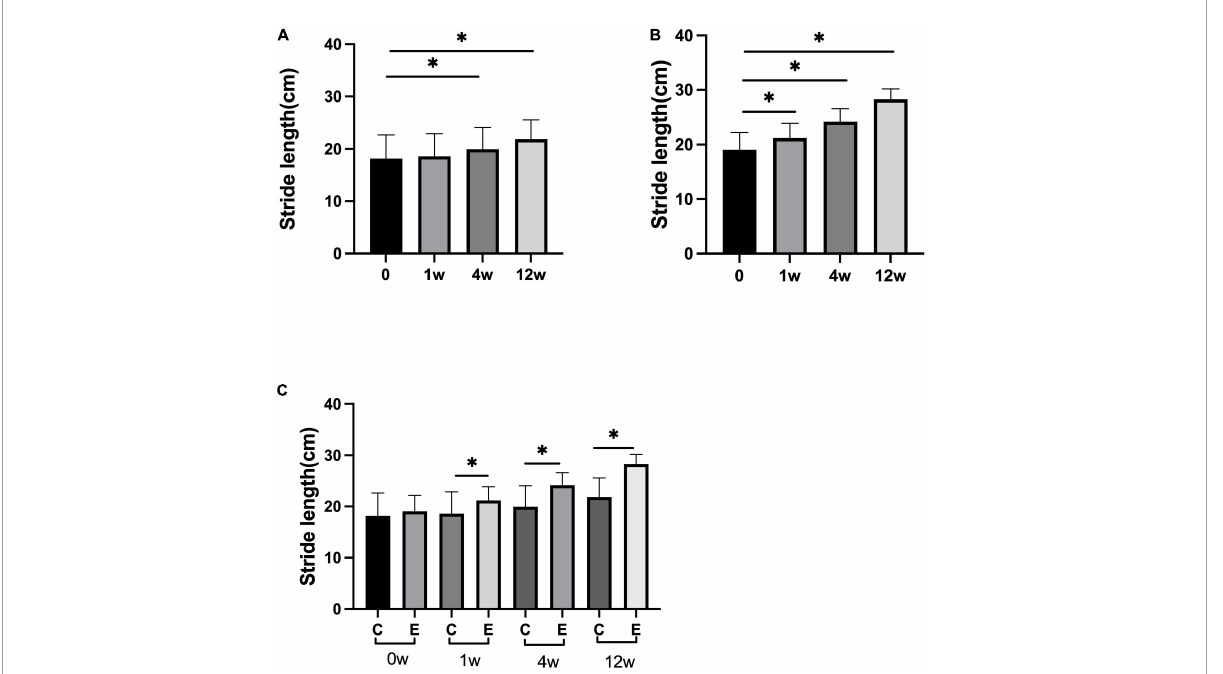
FIGURE5 Changes in stride length (cm). (A) Stride length at 1, 4, and 12 weeks compared with that at 0 week in control group; (B) stride length at 1, 4, and 12 weeks compared with that at 0 week in experimental group; (C) stride length at 0, 1, 4, and 12 weeks in experimental group compared with control group; ∗ p < 0.05.